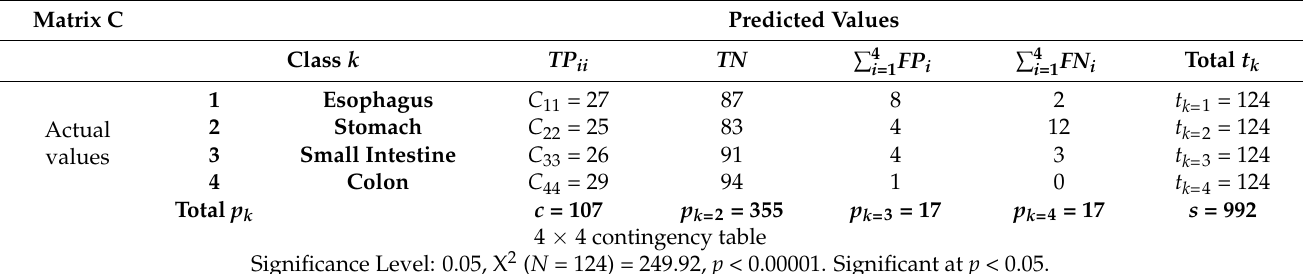
Table 4. Report from testing 496 frames (124 not seen before frames of each organ) with CNN model